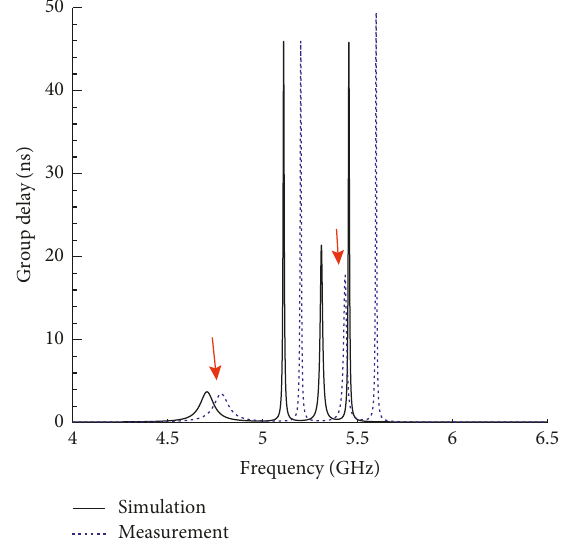
Figure 8: Simulated and measured transmission group delay corresponding to first proposed resonator